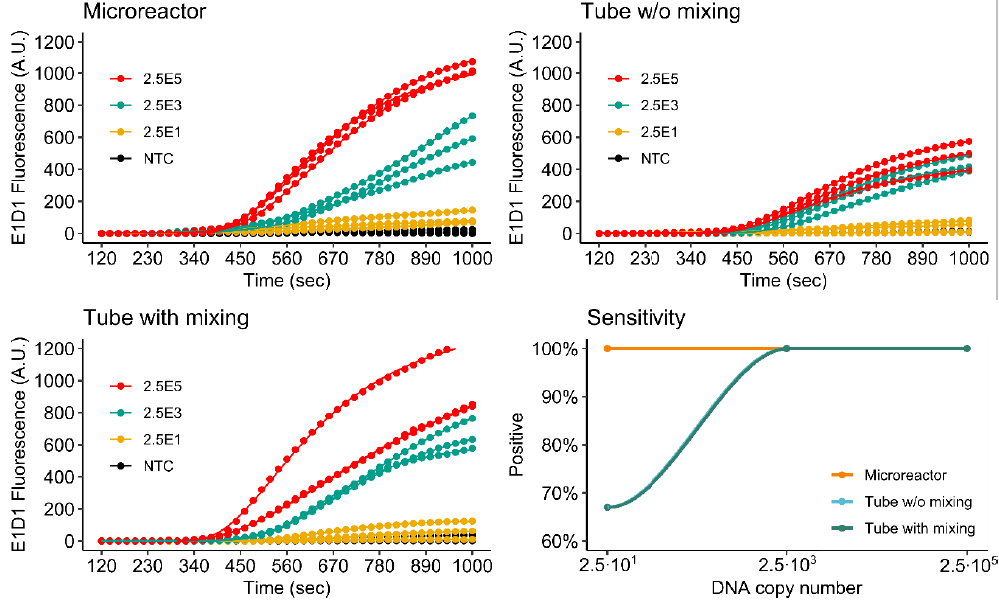
Figure 9. Detection of khe by singleplex rtRPA.